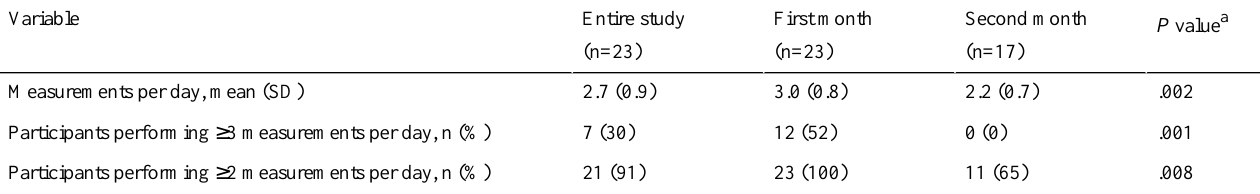
Table 2. Overview of compliance, calculated as the average amount of measurements performed per day, with optimal compliance considered as 3 measurements